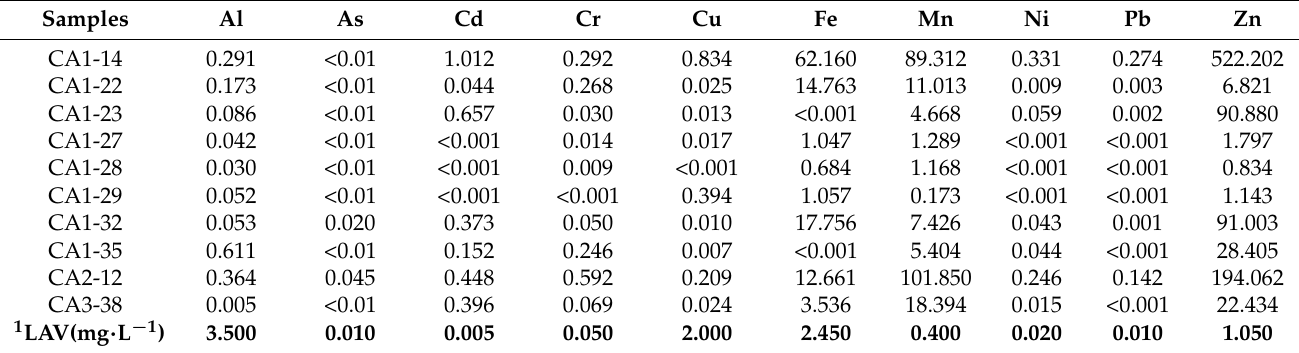
Table 1. Average values (mg · L − 1 ) of the elements analyzed in the interstitial waters for the dry season. Samples